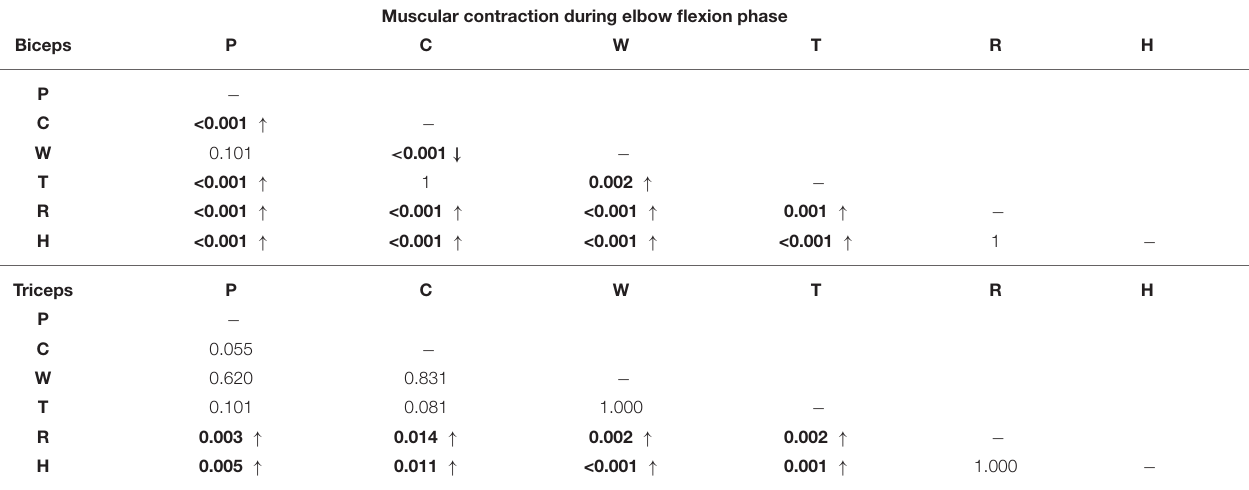
TABLE 3 | P -values results of the post-hoc analysis comparing integrated EMG (iEMG) index among training modalities during elbow flexion movement.